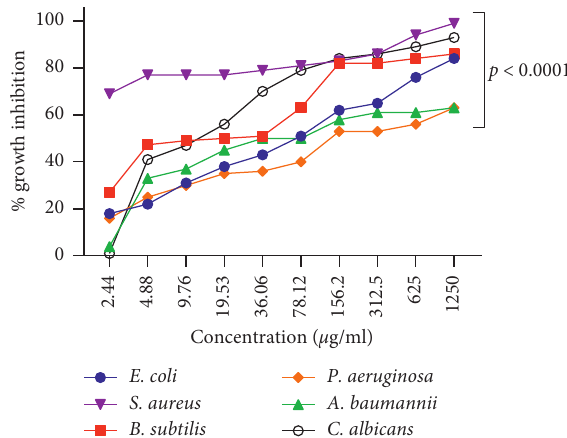
Figure 10: The growth inhibition happened by S. officinalis -me- diated ZnO-NP concentrations against Gram-positive strains ( B. subtilis and S. aureus ), Gram-negative strains ( A. baumannii, E. coli, and P. aeruginosa ), and C. albicans . This diagram showed that the S. officinalis -synthesized ZnO nanoparticles showed a powerful antibacterial effect for S. aureus and a weaker effect on P. aeruginosa .